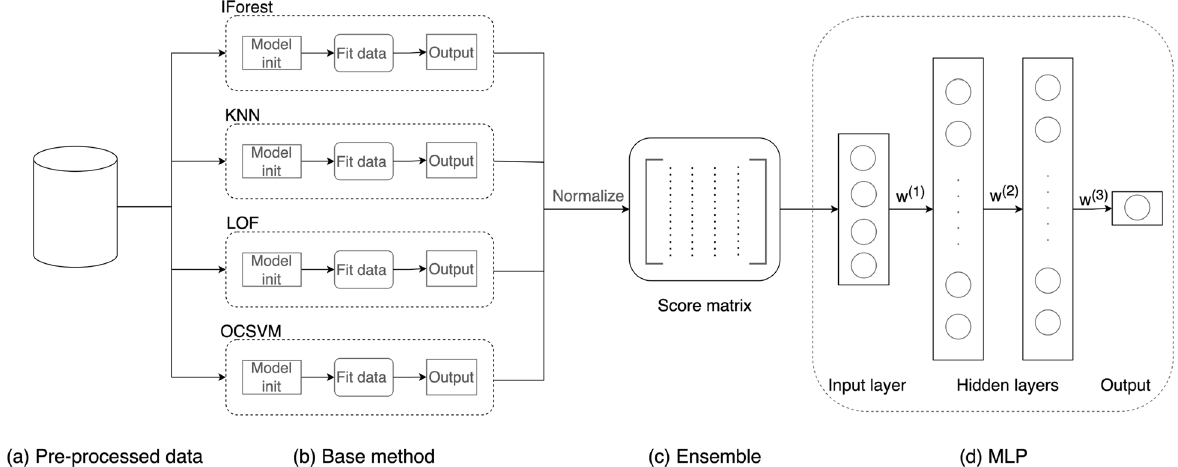
Fig. 3 The architecture of deep ensemble method includes four steps: (a)pre-processing data is sent to four (b)base methods; then after normalization, the (c)ensemble of their outputs forms a score matrix; we finally input the score matrix into an (d)MLP for